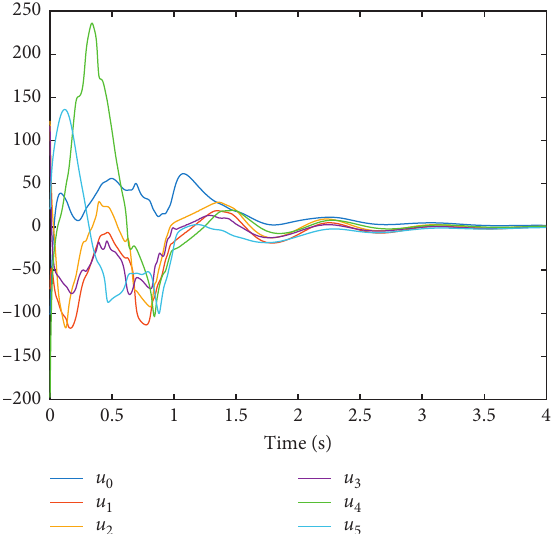
Figure 5: Trajectories of the control u